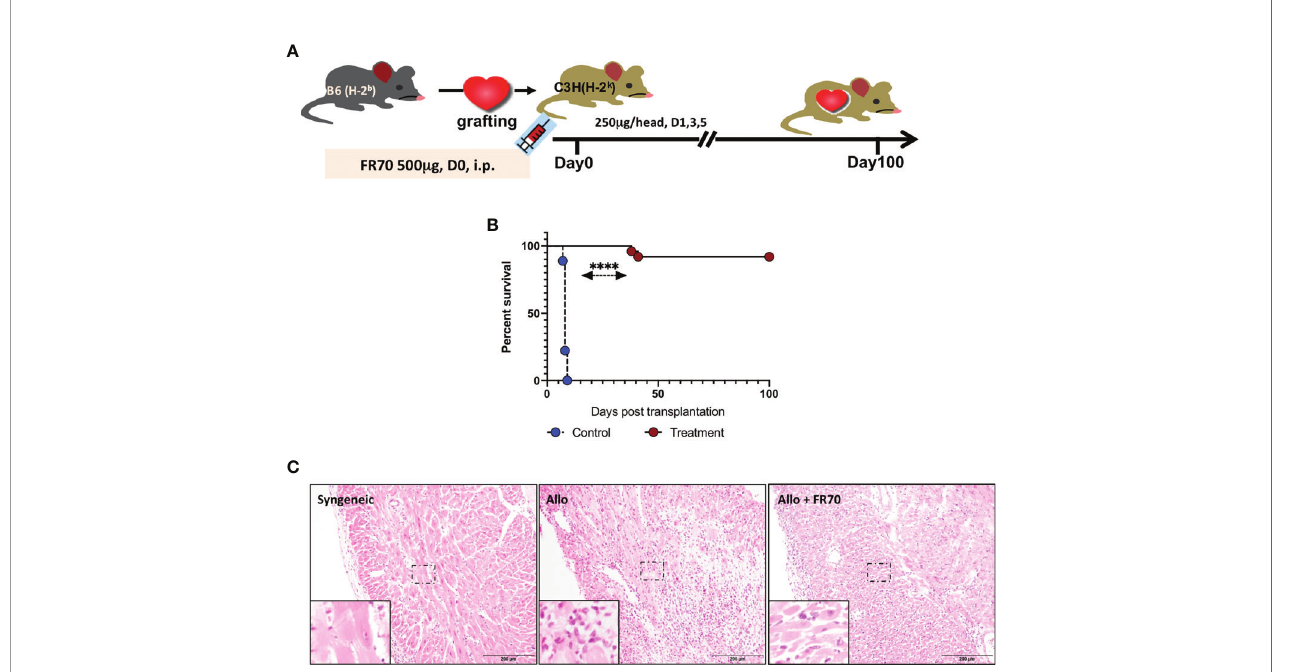
FIGURE 1 | Anti-CD70 antibody (FR70) treatment induced long-term acceptance of mouse cardiac grafts. (A) FR70 (500 µg) was intraperitoneally (i.p.) injected into C3H recipient mice immediately after heterotopic cardiac transplantation, and in the following 5 days, three additional half-dose (250 µg, i.p.) FR70 injections were performed. (B) The graft survival data are presented in detail. C3H recipients that underwent transplantation of a heart from B6 mice were either not treated or treated with FR70 (n = 18 mice for not treated group, n = 25 mice for treated group, mean ± SEM, pooled from fi ve independent experiments). The mean survival time (MST) is shown in Table 1 . A statistical evaluation of the graft survival was performed using Kaplan – Meier curves and compared using log-rank tests, ****p < 0.0001. (C) Histologic studies of harvested cardiac grafts were performed with hematoxylin – eosin (HE) staining.